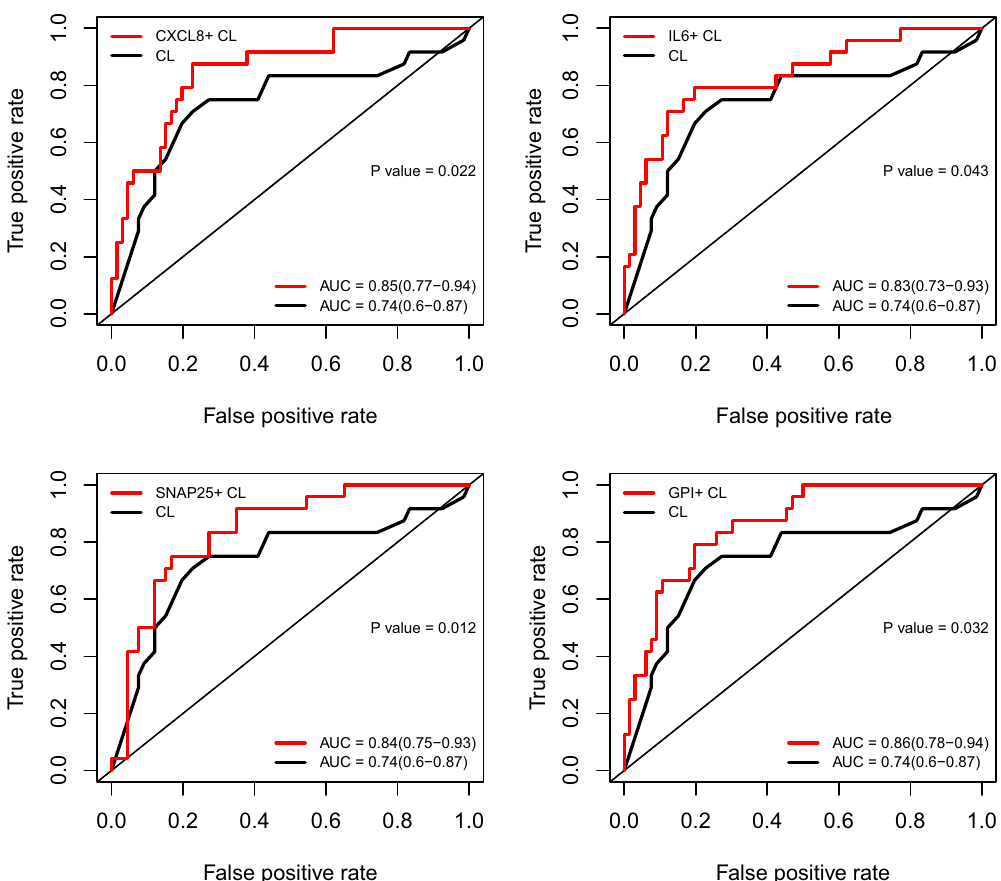
Figure 2. ROC curves for predicting imminent delivery. Each panel compares prediction by cervical length alone and models that combine cervical length with protein abundance. AUC: area under the ROC curve and 95% confidence interval. CL: cervical